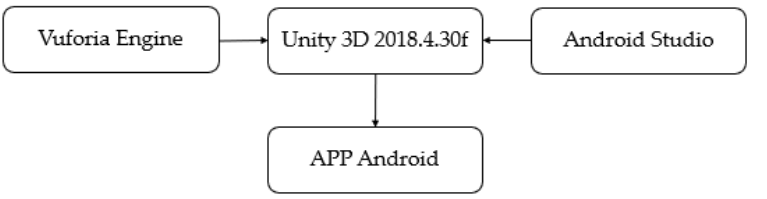
Figure 3. Workflow of the platforms used in the development of the Android APP.